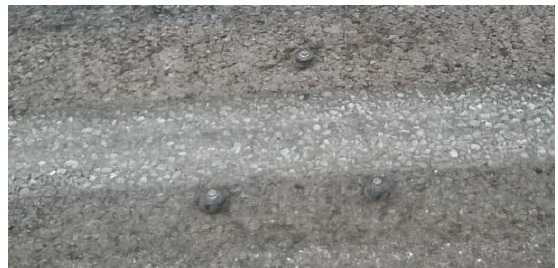
Figure 6. Control region of the track with reference marks